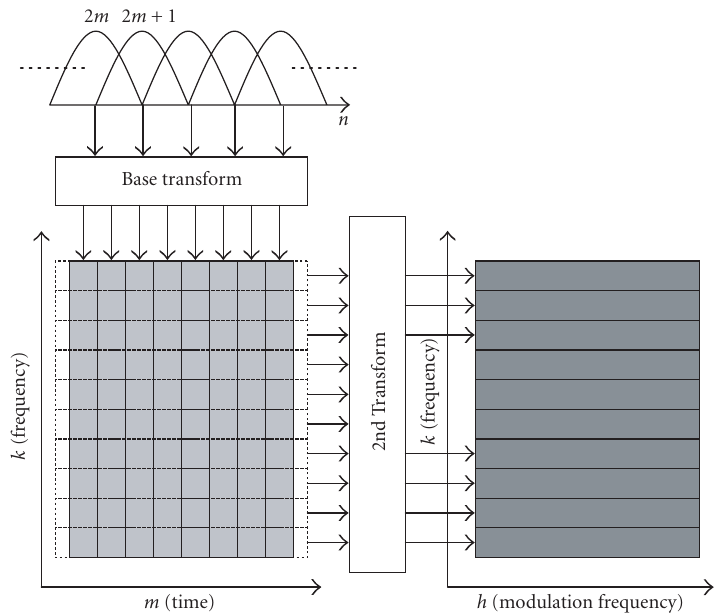
Figure 3: Simplified structure of the two-dimensional transform used in the new approach to audio coding [36]. The left matrix represents a magnitude of a perfect reconstruction and critically sampled filterbank. The detection operation previously mentioned was inherent in the magnitude operation. Signal phase was encoded separately and did not undergo the second transform.